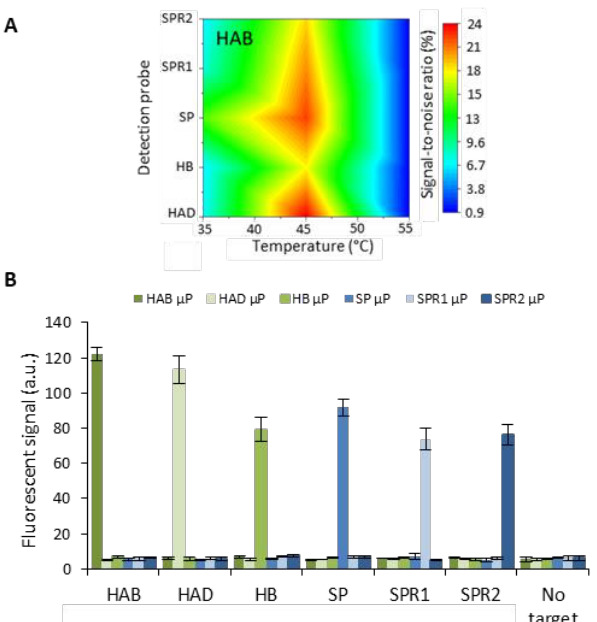
Figure 4. ( A ) Color map visualizing the signal-to-noise ratio for HAB target capturing at different temperatures. ( B ) Fluorescent signal for six different target sequences HAB, HAD, HB, SP, SPR1 and SPR2) obtained for a concentration of 250 pM target and a blank containing no target. Each channel, containing six different microparticle (µP) populations, was incubated with a sole target at 45 °C. The error bars represent one standard deviation ( n = 2).